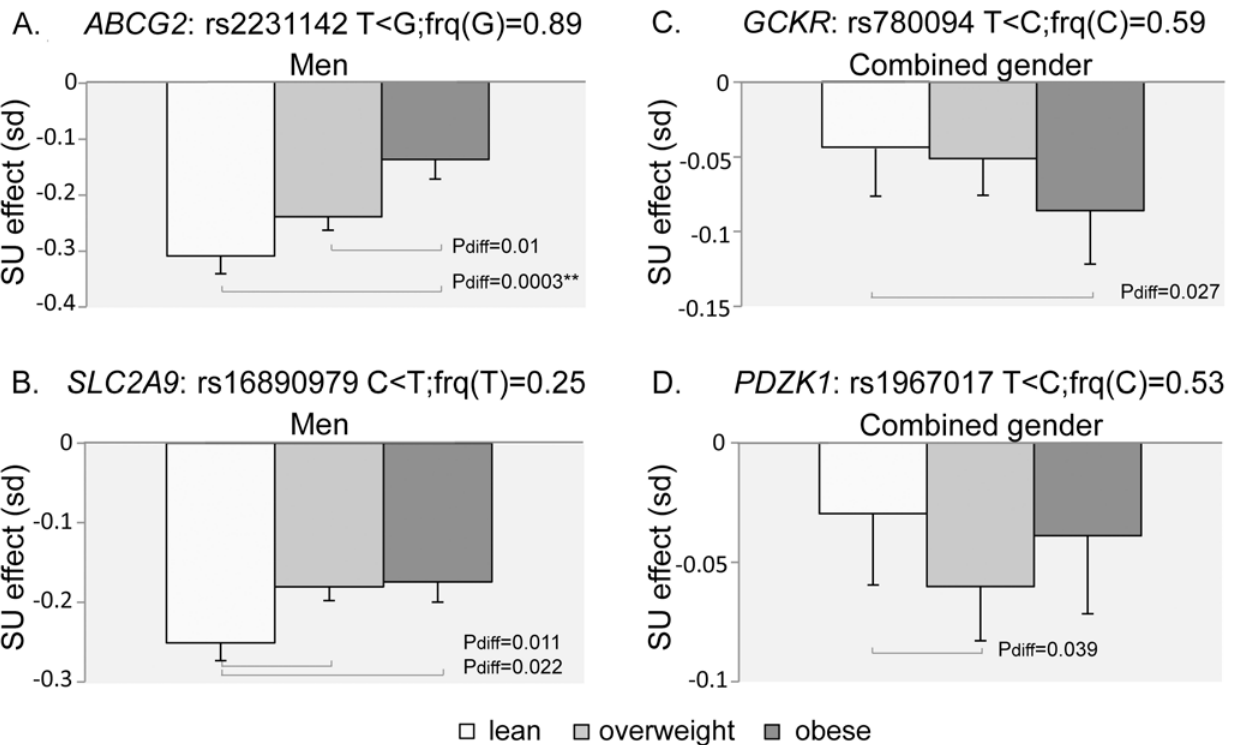
Fig 1. Mean effect across BMI strata of allelic substitutions at representative variants displaying genome-wide significant association with SU in at least one BMI stratum and displaying nominally significant difference in effect size across BMI strata. Effect size is on standardised age-adjusted SU levels. Error bars indicate the standard errors of the mean effect estimates within a BMI category. Horizontal lines indicate nominally significant (p < 0.05) differences in mean effect sizes between BMI categories, ** indicates significance at the 1% level taking into account the multiple comparisons performed. Differences in mean effect sizes between BMI strata were tested pairwise using the classical z-test, and P diff denotes the 2-sided test corresponding P-value. Lean: BMI < 25 kg/m 2 , overweight: 25 (cid:1) BMI (cid:1) 30 kg/m 2 , obese: BMI > 30 kg/m 2 .